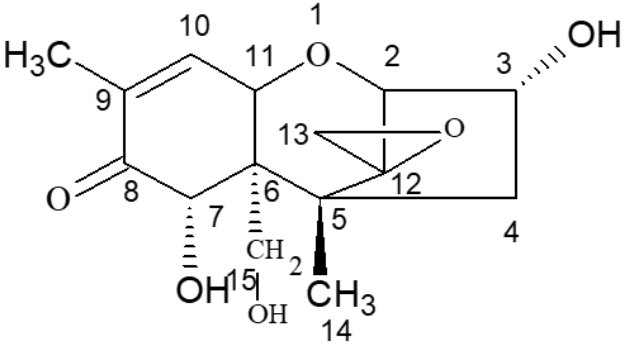
Figure 6. Molecular structure of DON.